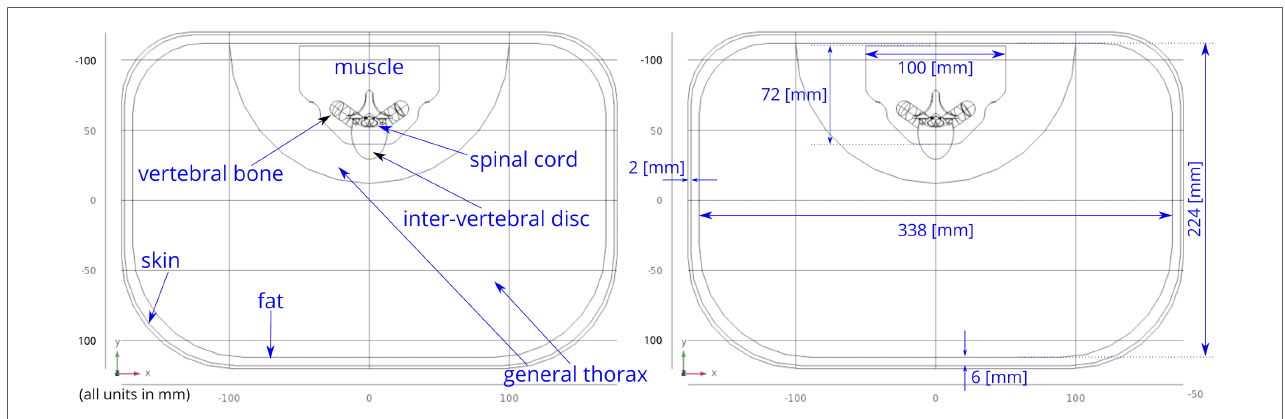
FIGURE 1 Abdomen cross-section. The general thorax section has been divided into two sections — the outer section has a coarser mesh, the inner section near the spinal cord has fi ner mesh. This division allows ef fi cient meshing while resolving the electric fi eld